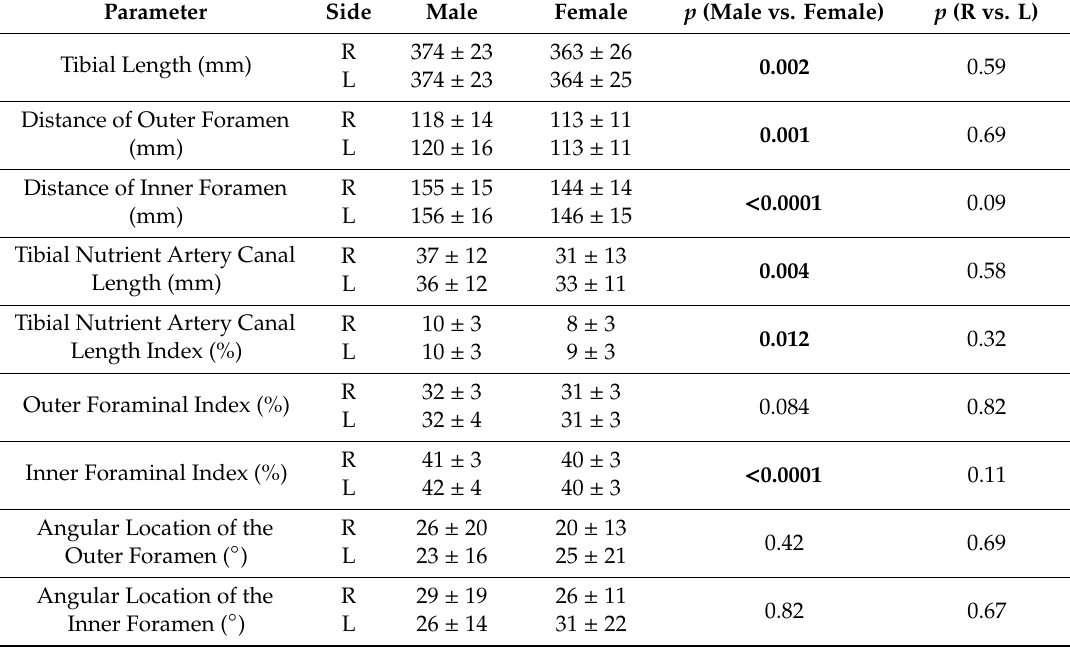
R = right side; L = left side; values are given as arithmetic mean ± standard deviation. Bold denotes statistical